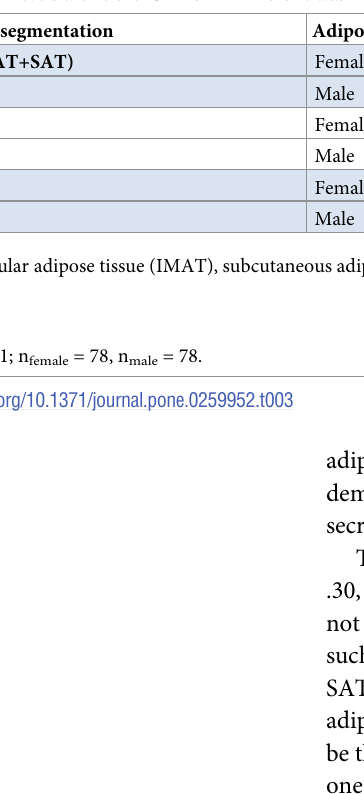
Table 3. Sex-stratified comparison of correlation coefficients between adiponectin and fat tissue segmentation results. The ratio between subcutaneous adipose tissue and intramuscular adipose tissue (SAT/(SAT+IMAT) shows a significant correlation with serum adiponectin levels for both males and females, whereas the correlation of adiponectin levels with either SAT or IMAT alone was not significant for both sexes.